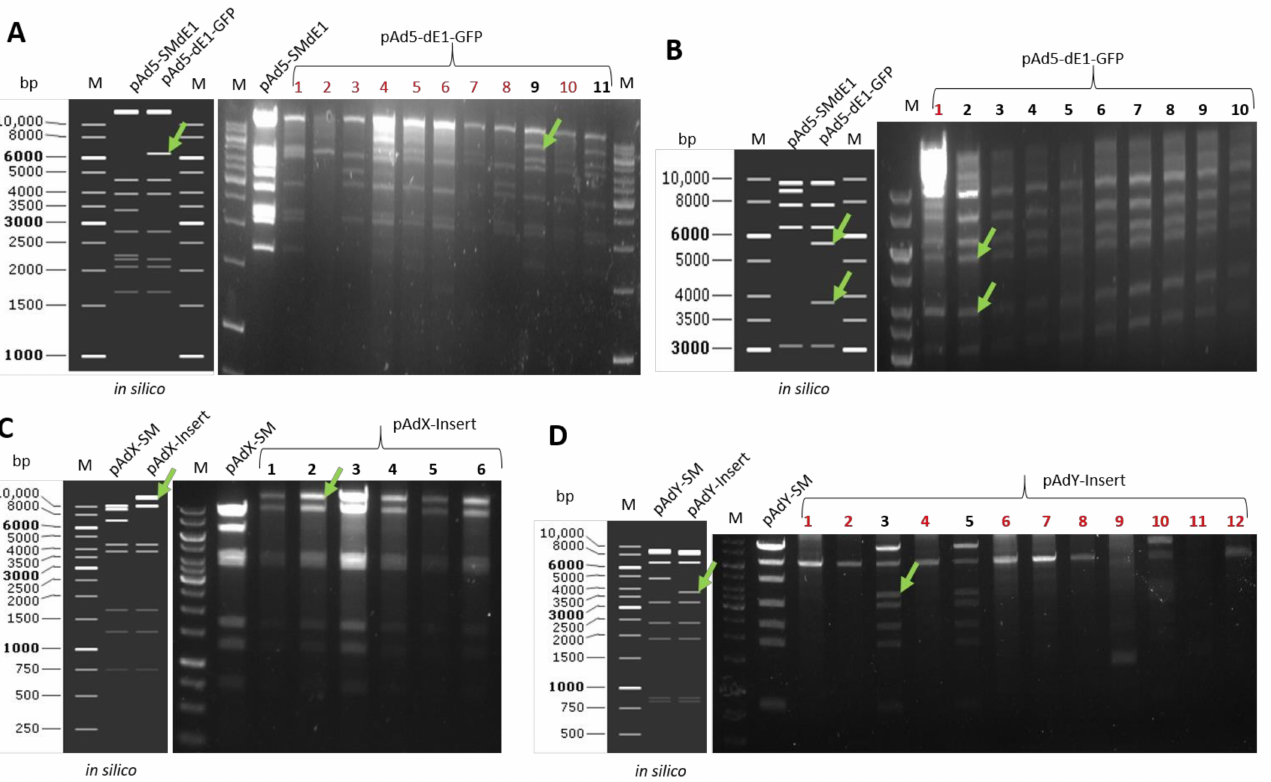
Figure 6. Example of plasmid restriction digest after counter-selection. Indicated with green arrows are the bands appearing only in positive clones. The plasmid digest pattern is exemplified by transgene (GFP) insertion into E1 region of Ad5. Indicated with red numbers are the clones with a wrong digestion pattern. ( A ). The digest of both parental plasmid pAd5-SMdE1 and the aimed plasmid pAd5-dE1-GFP with PvuI. Plasmids number 9 and 11 are positive for transgene insertion evidenced by the additional 6.1 kb band and the absence of the 3.4 kb band. Then, the two plasmids were re-transformed into normal competent bacteria. ( B ). The digest of both parental plasmid pAd5- SMdE1 and the aimed plasmid pAd5-dE1-GFP after re-transformation, here the restriction enzyme DraIII was used, all clones but not the clone number 1 were identified as clean-single-type correct plasmid. ( C ). The digest of both parental plasmid pAdX-SM and the aimed plasmid pAdX-Insert with BspHI, all six checked clones were positive evidenced by the bands shift. ( D ). The digest of both parental plasmid pAdY-SM and the aimed plasmid pAdY-Insert with SmaI, two (number 3 and 5) out of 12 checked clones were positive evidenced from the right digest bands